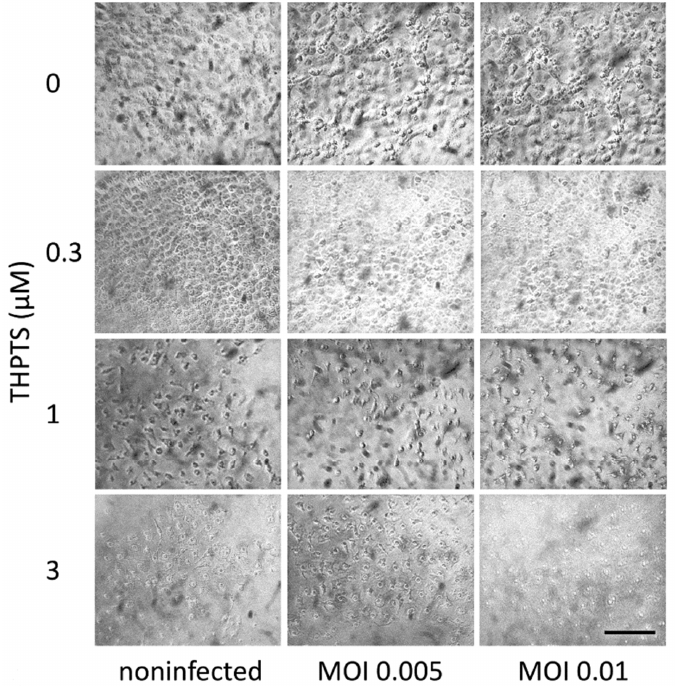
Figure 3. Viral cytopathic effects in Vero E6 cells after infection with SARS-CoV-2 and subse- quent (single) PDI treatment. Three days after infection, cell cultures showed clear signs of viral cytopathic effects as a consequence of SARS-CoV-2 infection. When infection was followed by one single PDI for 10 min (light dose 7.8 J/cm 2 ) with THPTS at indicated concentrations, viral cytopathic effects were mitigated in a concentration-dependent manner. At 1 µM THPTS, toxic effects of the PDI treatment were observed. Scale bar indicates 100 µm. Repeated PDI with THPTS concentrations of 0.1 µM partially and 0.3 µM completely prevented CPE signs when compared to non-infected cell cultures, while PDI with 1 µM THPTS and above caused significant changes in cell morphology, most likely due to the cytotoxicity of the PDI treatment under these conditions (Figure 4).